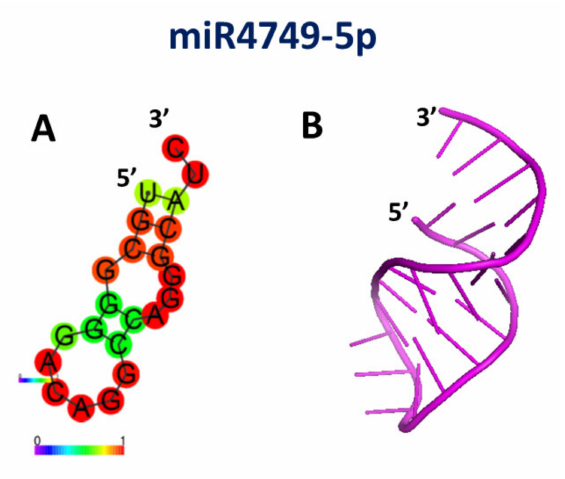
Figure 3. ( A ) Drawing of the best model for the secondary structure of miR4749-5p; colors of the spots indicate the corresponding pair-base probability (see the scale at the bottom). ( B ) Graphical representation of the best 3D model for the tertiary structure of miR4749-5p, as derived using the secondary structure in ( A ) together with related dot-bracket notation. Adapted from ref.